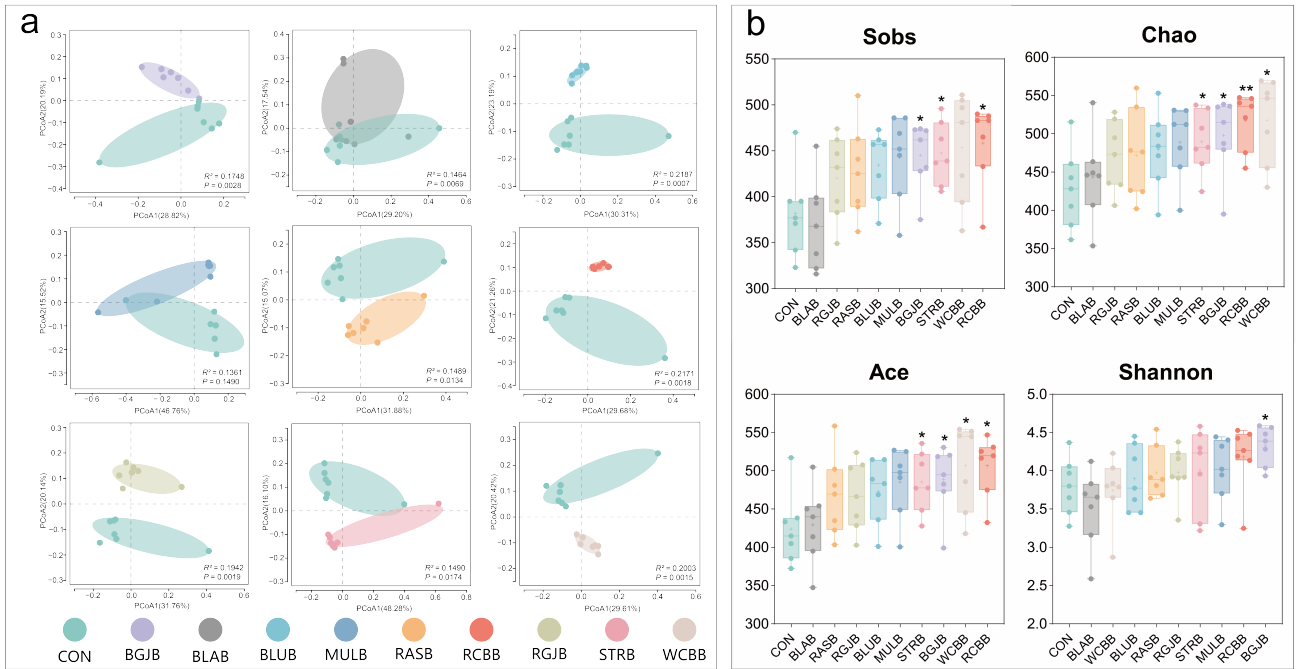
Figure 3. Administration of berries extracts significantly altered the gut microbiota composition. ( a ) Principal coordinate analysis (PCoA) plot based on Unweighted UniFrac matrix of the gut microbiota composition at the OTU level from different groups (n = 7/group). Pairwise comparisons using the permutational multivariate analysis of variance (PERMANOVA) test. ( b ) Alpha diversity analysis of gut bacterial richness (sobs, ace and chao indices) and diversity (Shannon index) from different mouse groups (n = 7/group), statistical significance was determined by Mann-Whitney U test for two groups comparisons. *, compared with control group. *, p < 0.05; **, p < 0.01.